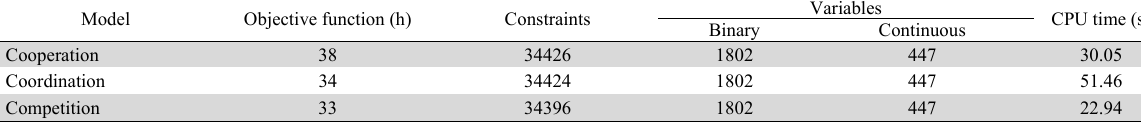
Model sizes and computational statistics for each policy at Example 1